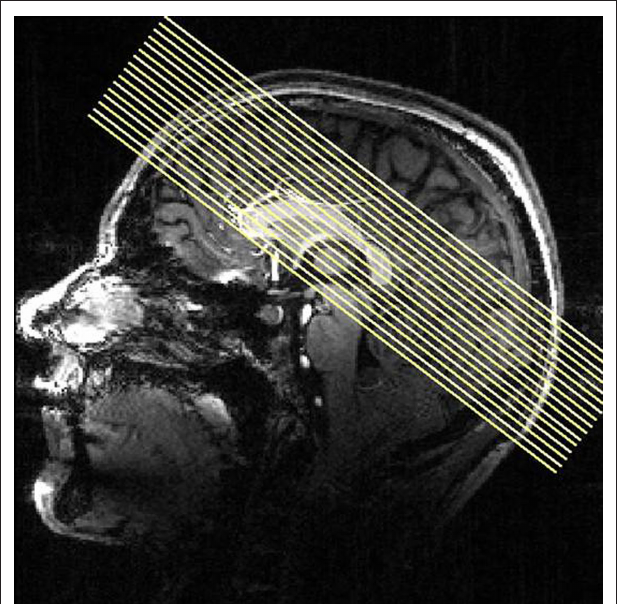
FIguRe 1 | Orientation of functional slices during fMRI session. Sixteen slices were acquired in an interleaved